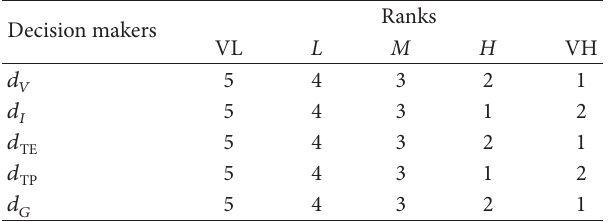
Table 3: Ranks of preference.